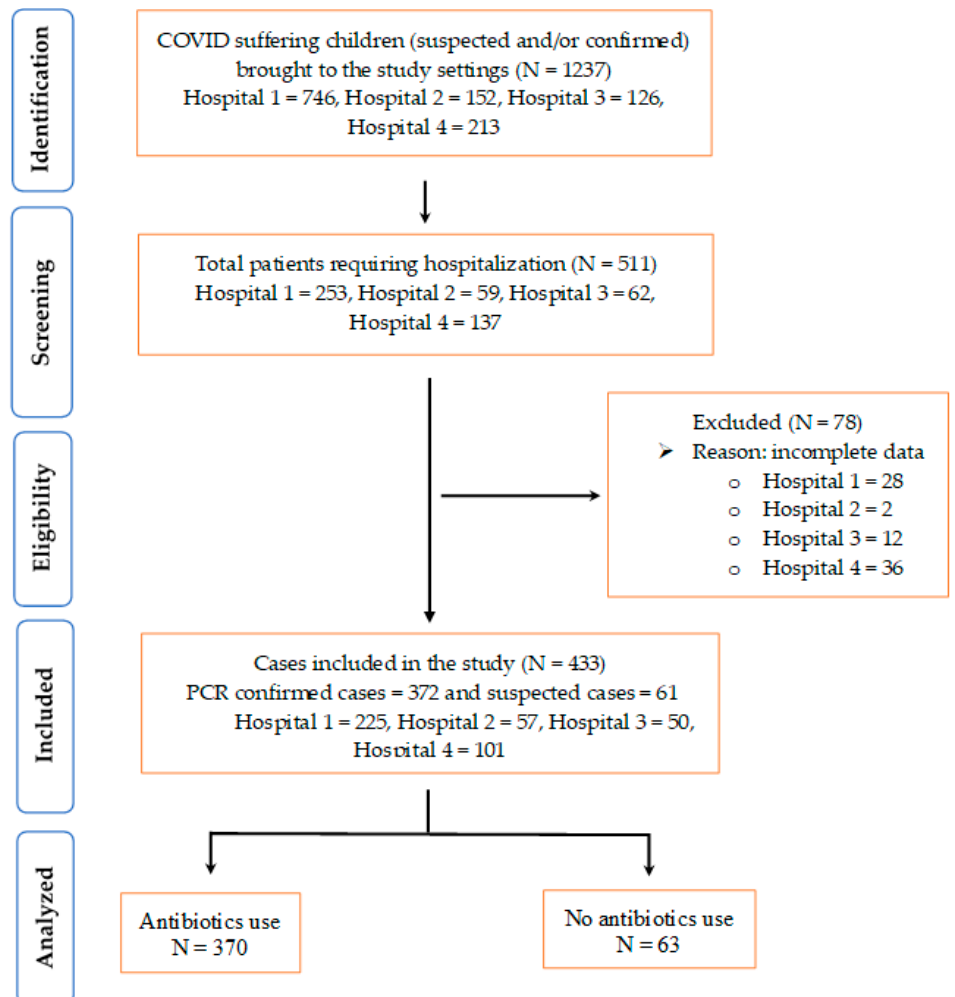
Figure 1. Flow chart of identification of COVID patients aged ≤ 12 for inclusion in the study.